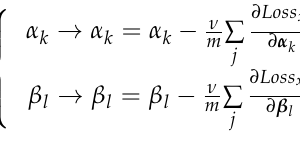
Figure 1. Structure of presented MLP